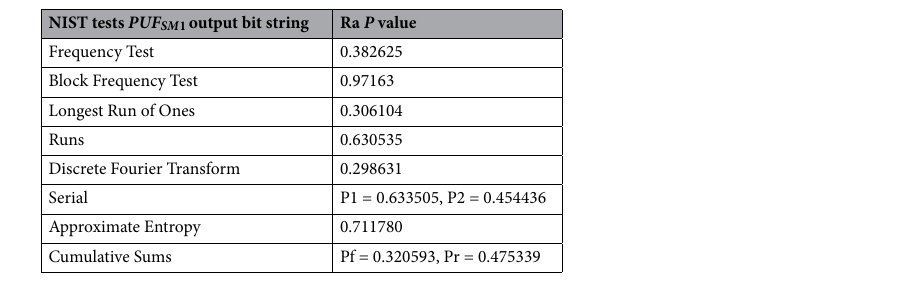
Table 11. NIST 8 tests’ results for PUF SM 1